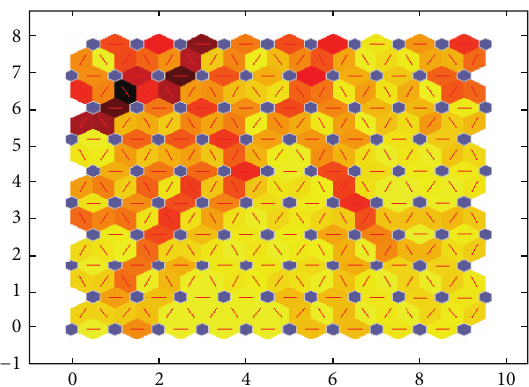
Figure 3: The cities SOM neighbor weight distances (Rapid Miner